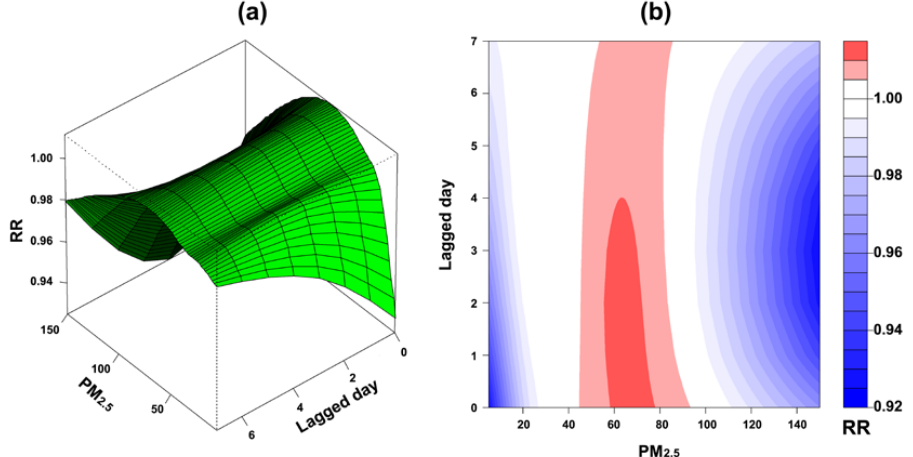
Figure 4. Transformed estimated cross-basis function for PM 2.5 : ( a ) The three-dimensional plot shows the variation of relative risk (RR) of children’s asthma along with PM 2.5 concentration and lagged day; ( b ) The contour plot shows the hot spot of RR of children’s asthma in a coordinate of PM 2.5 concentration and lagged day.